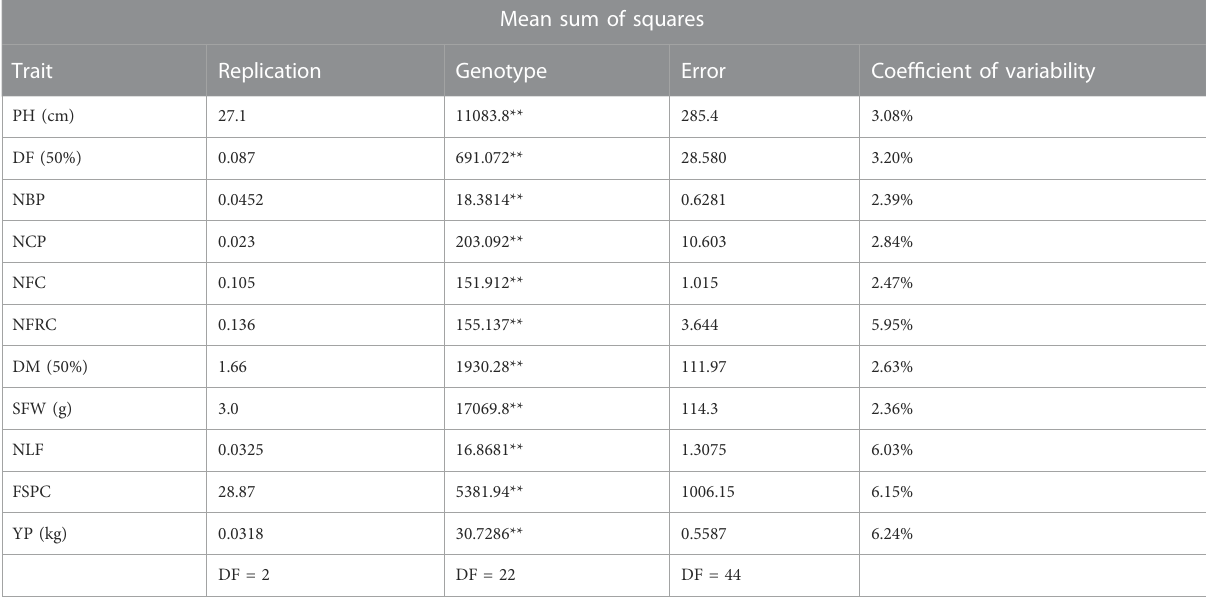
TABLE 2 Analysis of variance (ANOVA) for different yield traits.